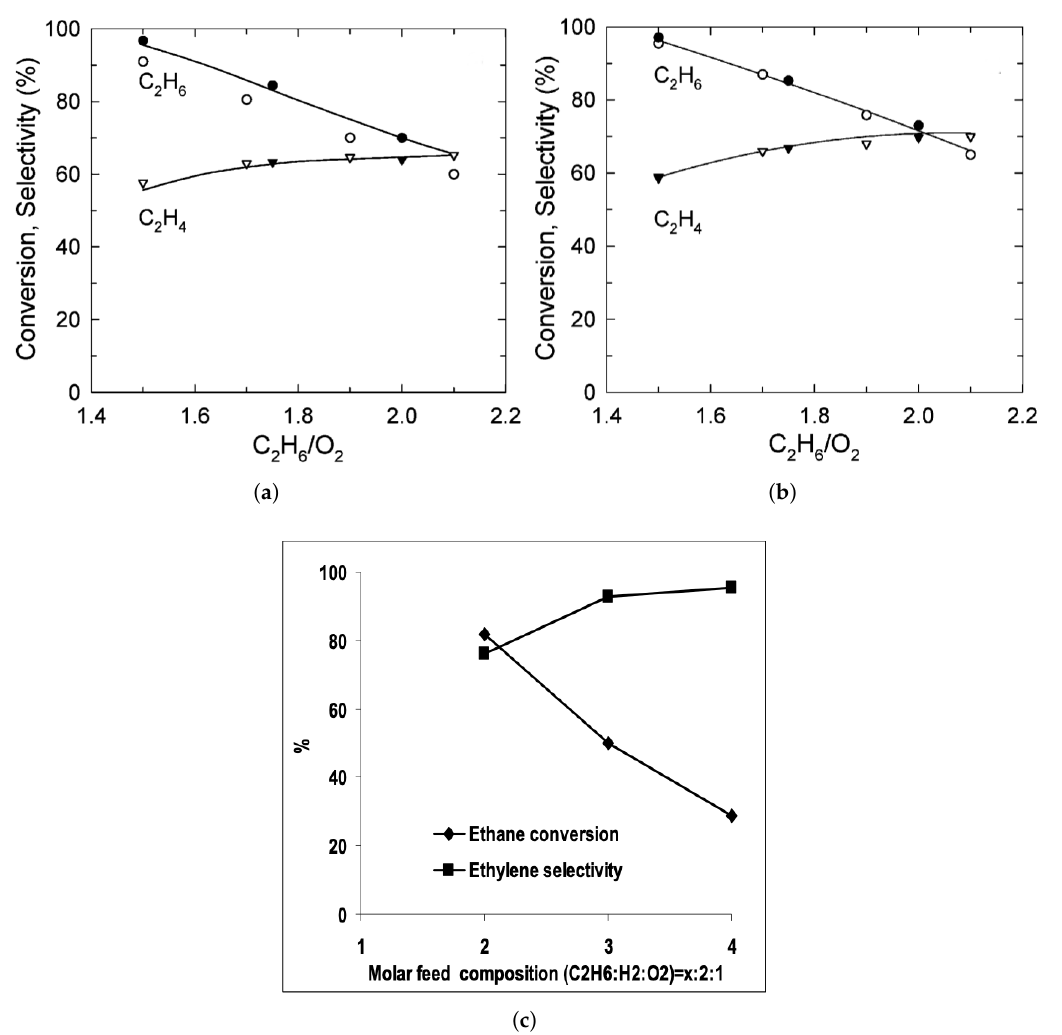
Figure 4. Ethane conversion and ethylene selectivity versus molar ratio of C 2 H 6 and O 2 in the reactor feed obtained from CFD models, represented by lines (points are experimentally obtained results). ( a , b ) Donsì et al. results on Pt ( a ) and Pt/Sn catalyst ( b ). (Reprinted with permission from [7]. Copyright 2005 American Chemical Society); ( c ) Ethane conversion and ethylene selectivity results form Stefanidis and Vlachos. (Reprinted with permission from